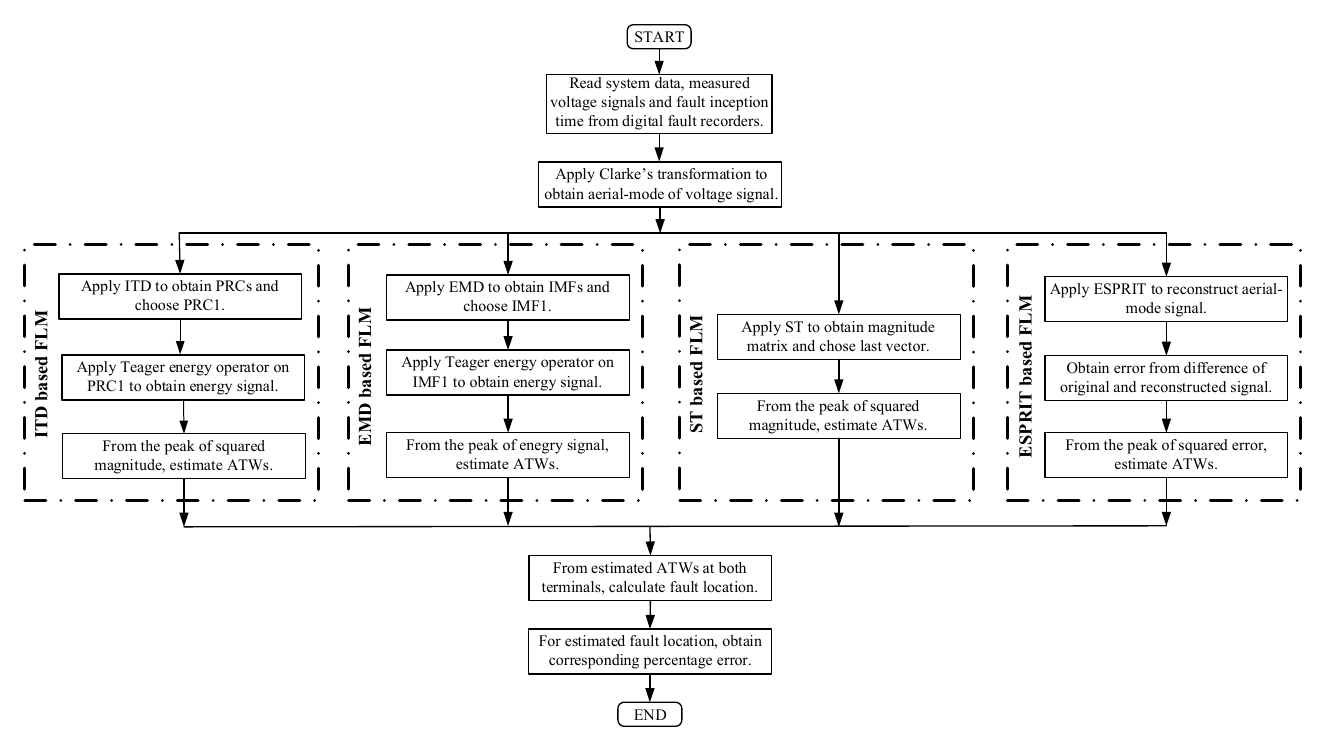
Figure 3. Flowchart of FLMs used in this work.